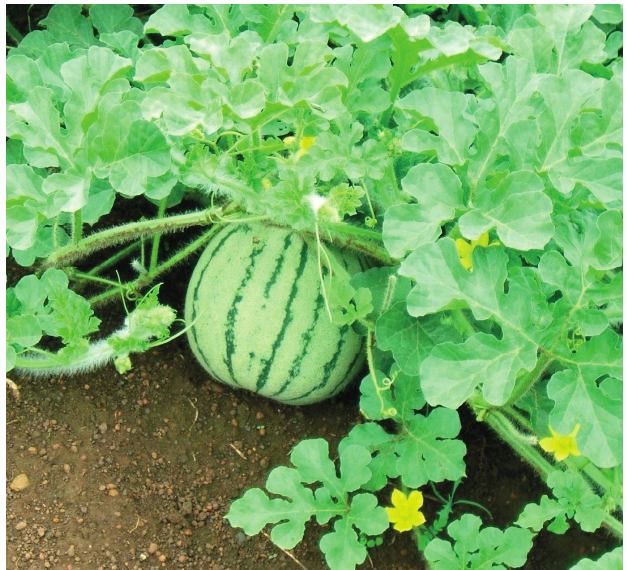
Figure 9. Wild watermelon. Source